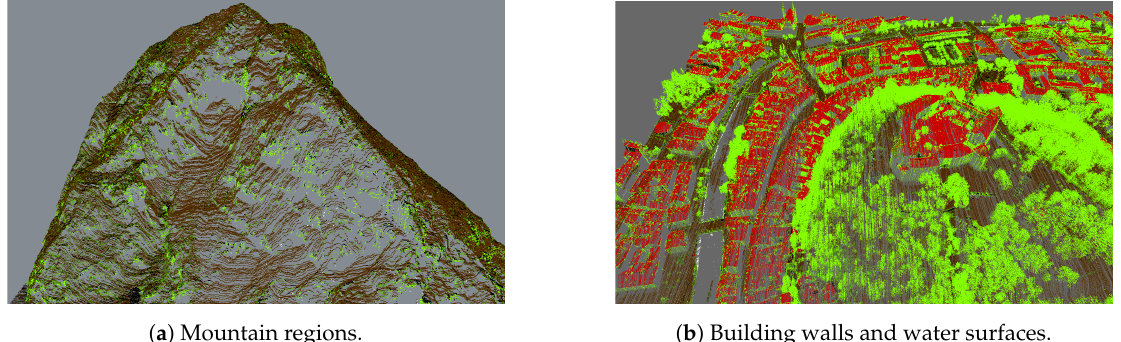
Figure 1. Missing points due to the steepness of the mountain ( a ), in building walls ( b ) and due to refraction and/or absorption on water surfaces ( b